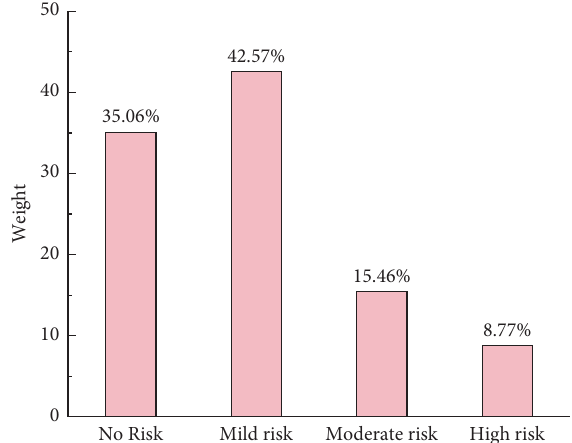
Figure 8: Safety assessment results of pipeline disaster in per- mafrost region of China-Russia crude oil.